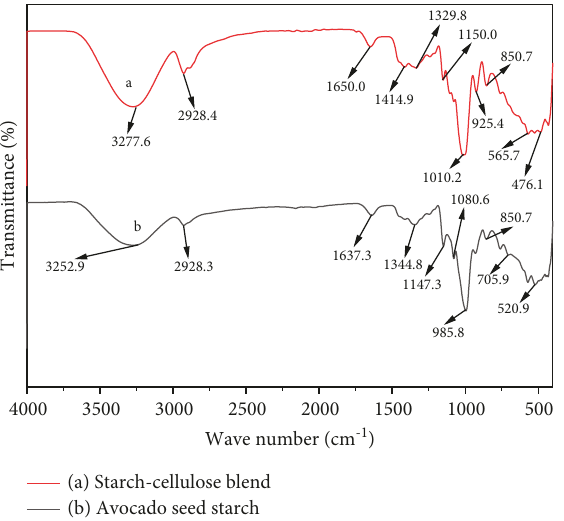
Figure 3: The FTIR spectra: (a) the starch-cellulosic blend and (b) the avocado